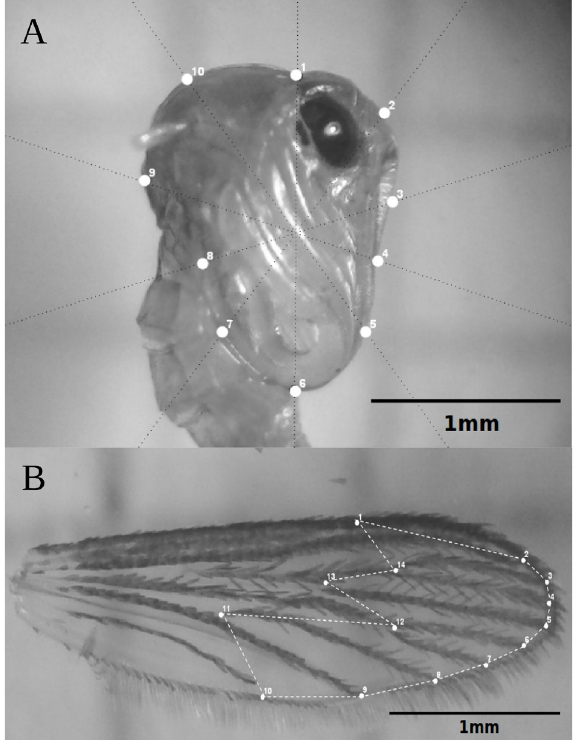
Figure 1. A - Cephalothorax of Aedes albopictus pupa showing the landmarks (1-10) disposition; landmarks 2-5 and 7-10 were treated as sliding; B - Right wing A. albopictus showing the landmarks (1–14) disposition. The polygon enclosed by the points conform the configurations